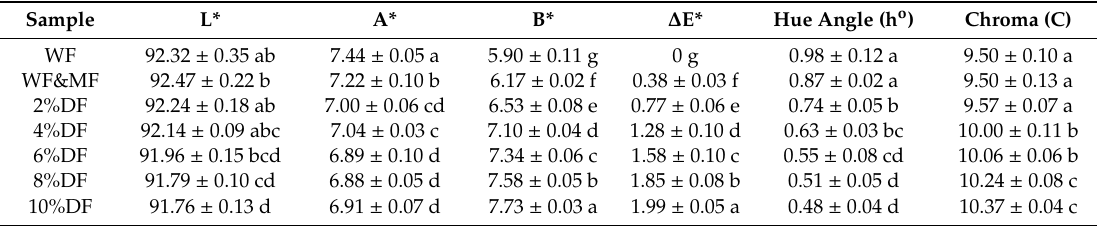
Table 3. Color evaluation of steamed bread with steamed millet flour and DF ( n = 6).